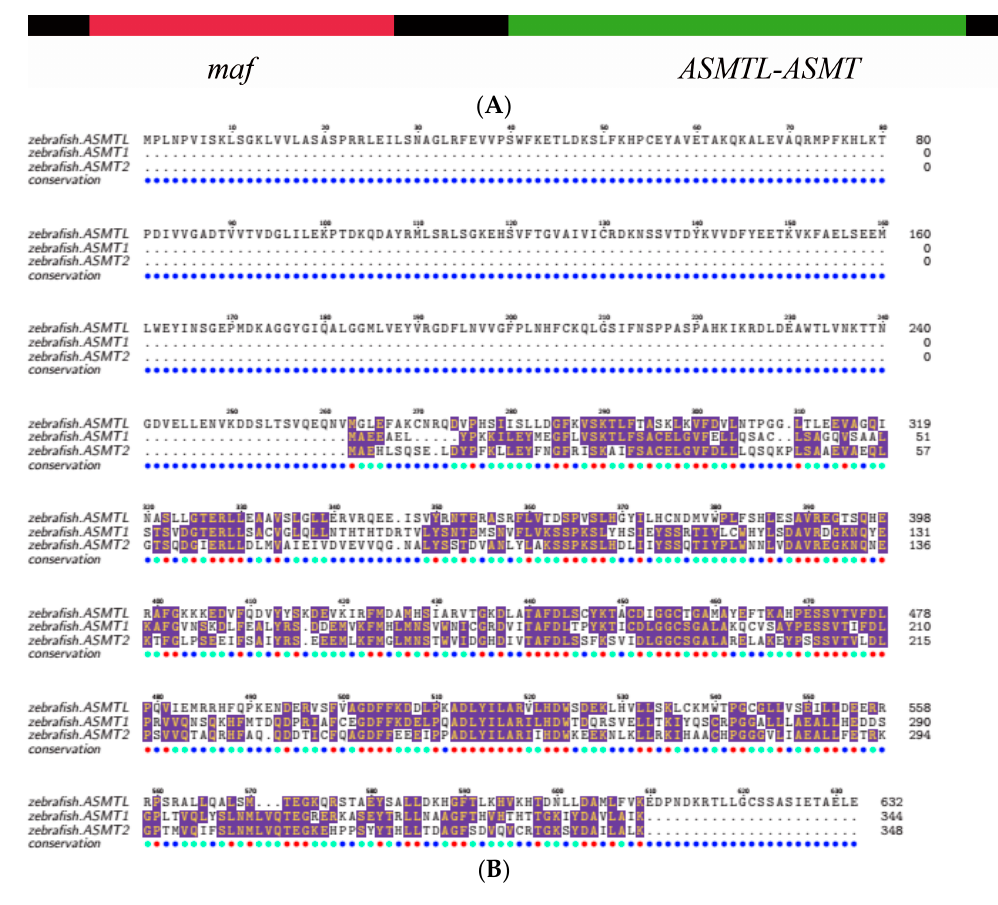
Figure 3. Alignment of ASMT protein sequences of zebrafish. ( A ) ASMTL has two different domains, with homology to two different genes ( maf and ASMTL-ASMT ; modified from [22]). ( B ) Similarity of the C-terminal of ASMTL (ASMTL-ASMT) to ASMT1 and ASMT2. See more details about the exon boundary in Figure